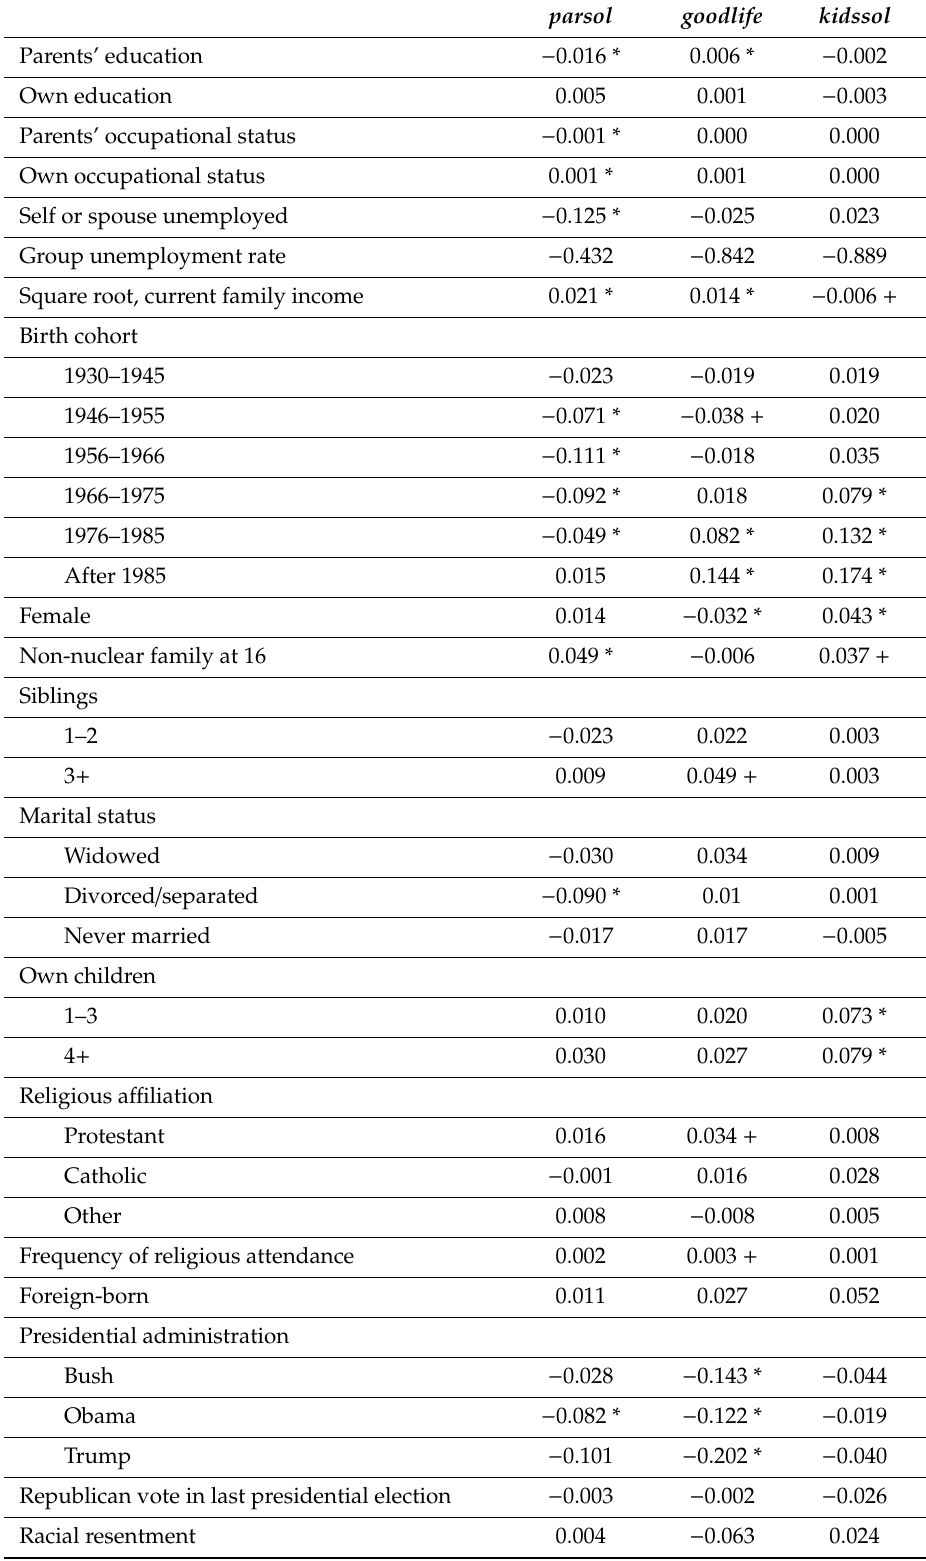
Table 3. Models predicting perceived mobility among White respondents only. parsol